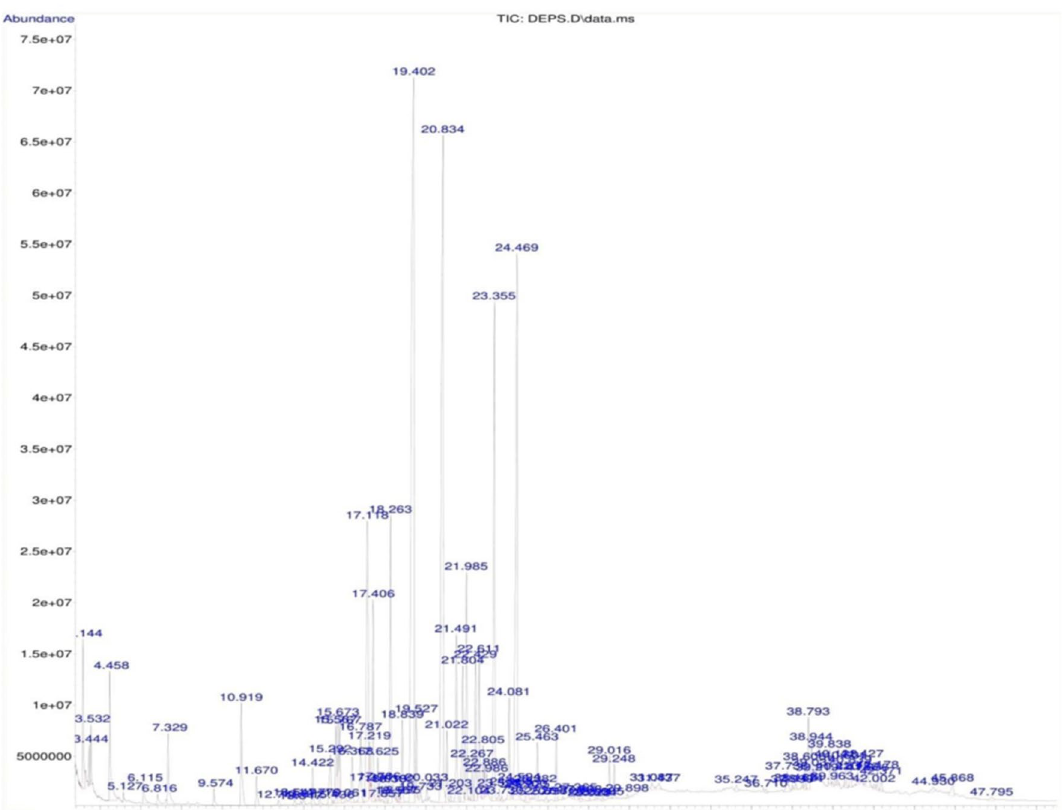
Figure 10. Gas Chromatogram of acid-hydrolysed and derivatised exopolysaccharide of the diatom Nitzschia palea showing different monosaccharide